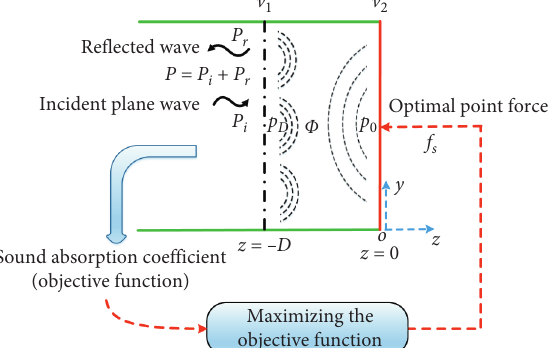
Figure 1: Side view of the proposed active